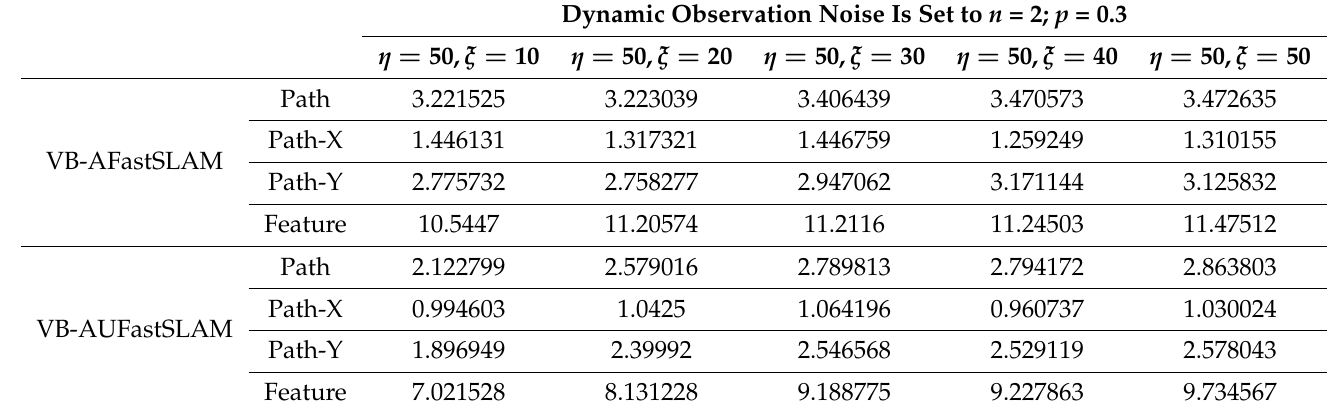
Table 6. RMSE comparison with large error initialization (m).